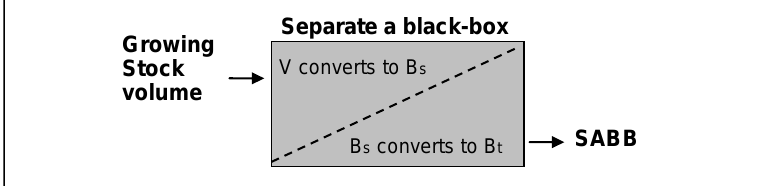
Figure 1. A diagram of volume-SABB relationship analysis borrowing a simple concept from black-box system identification. The gray rectangle is assumed as a black-box. It includes two sub-modules (B t and B s ) expressed by Parametric Equations (PEs).